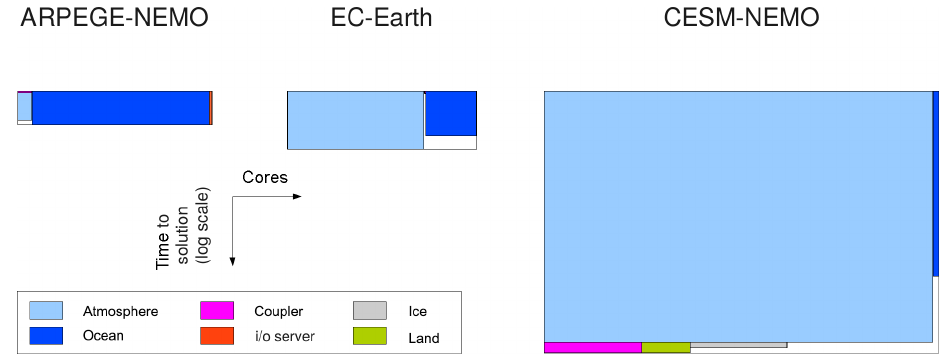
Figure 2. Component layout of three ESMs, in processor-time space (time increasing downward). Each box represents a component which is integrated either concurrently (coarse-grained concurrency; see text), in which case it is shown alongside the other components running at the same time, or sequentially, in which case it is shown below the previous component. The bounding rectangle shows the total cost of the coupled system, including waiting times due to load imbalance. Adapted from Fladrich and Maisonnave